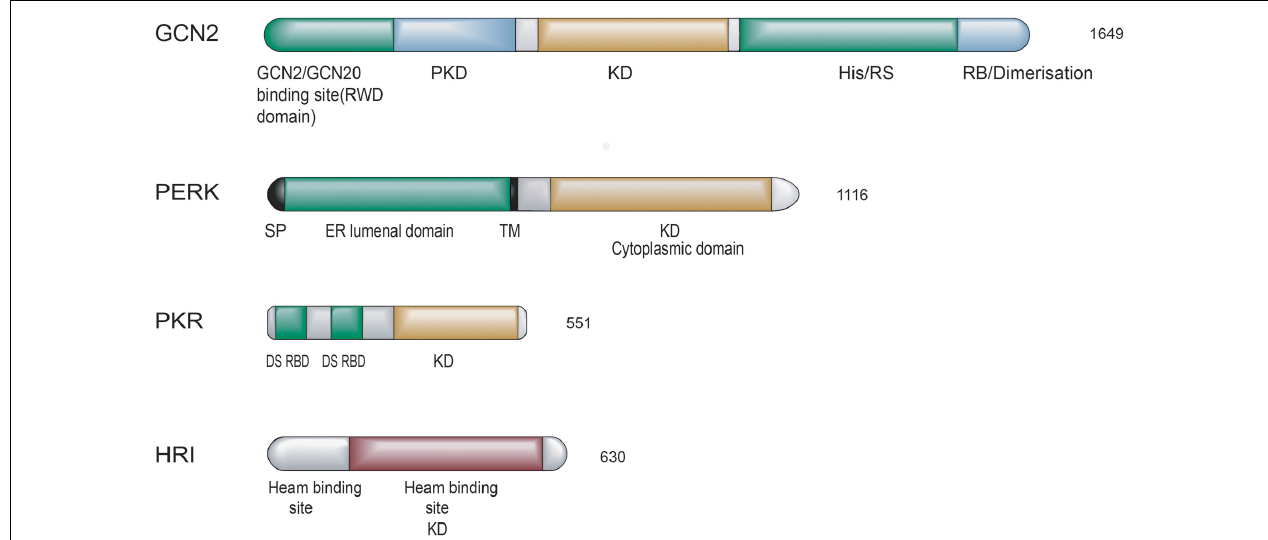
FIGURE 1 | Schematic diagram of the domain organization of the four mammalian eIF2 α kinases. Polypeptides are boxes running from N- to C-terminal domains from left to right. Length in amino acids is of proteins. The abbreviations of domains are listed: SP, signal peptide; TM, transmembrane domain; KD, kinase domain; DS RBD, double-stranded RNA binding domain; PKD, pseudokinase domain; His/Rs, histidyl-tRNA synthetase-related domain; RB, ribosome binding. Domains involved in sensing stress signals/activation are in green and black. Kinase domains are yellow and brown, other domains are colored blue, and domains are drawn to